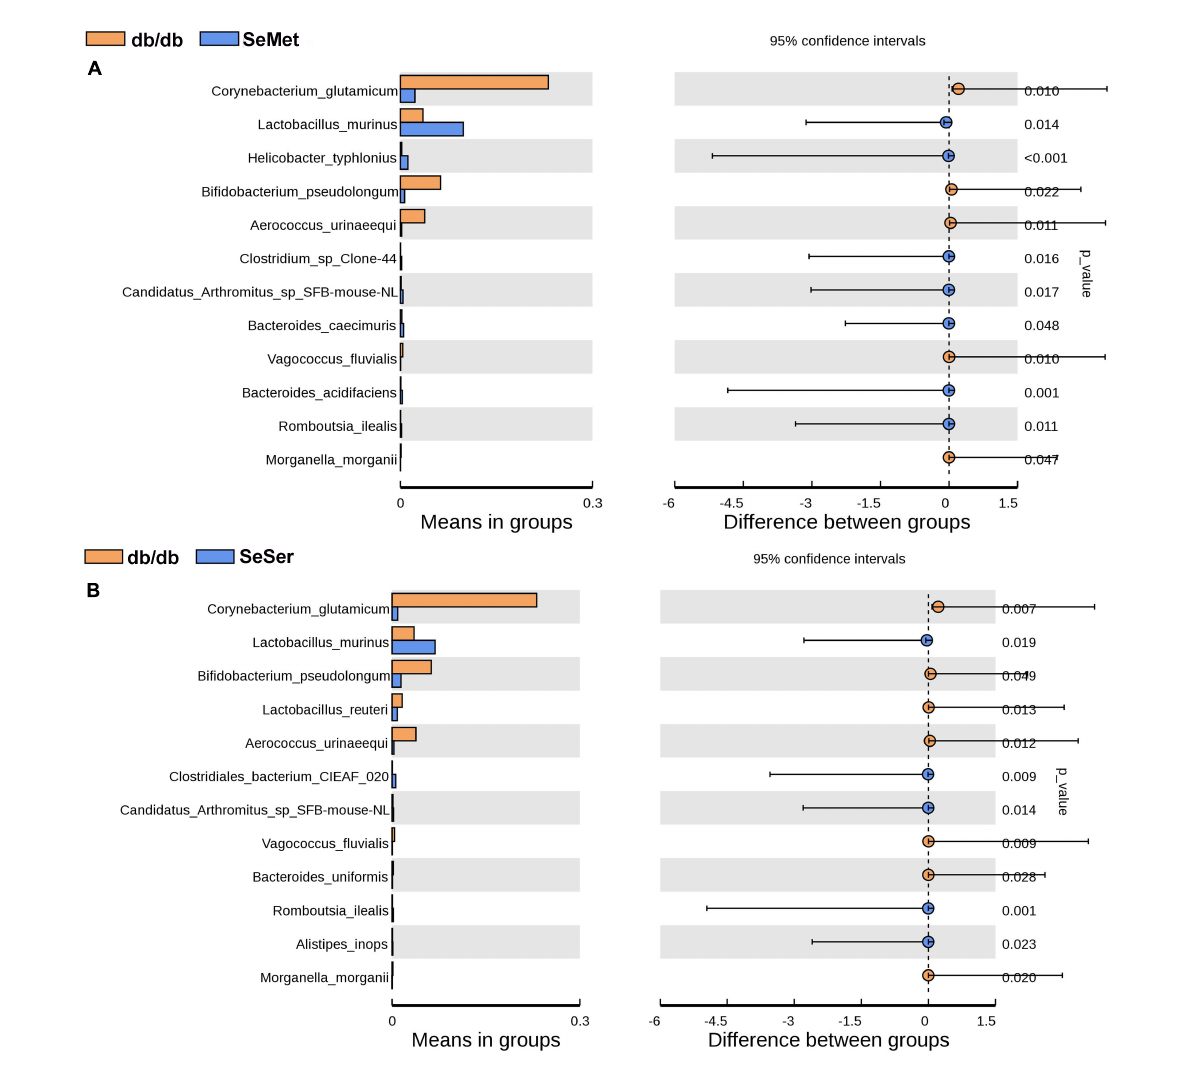
FIGURE5 The difference of microbe abundance in the db/db, SeMet and SeSer groups by using T-test analysis. (A) Difference between the db/db and SeMet group; (B) difference between the db/db and SeSer